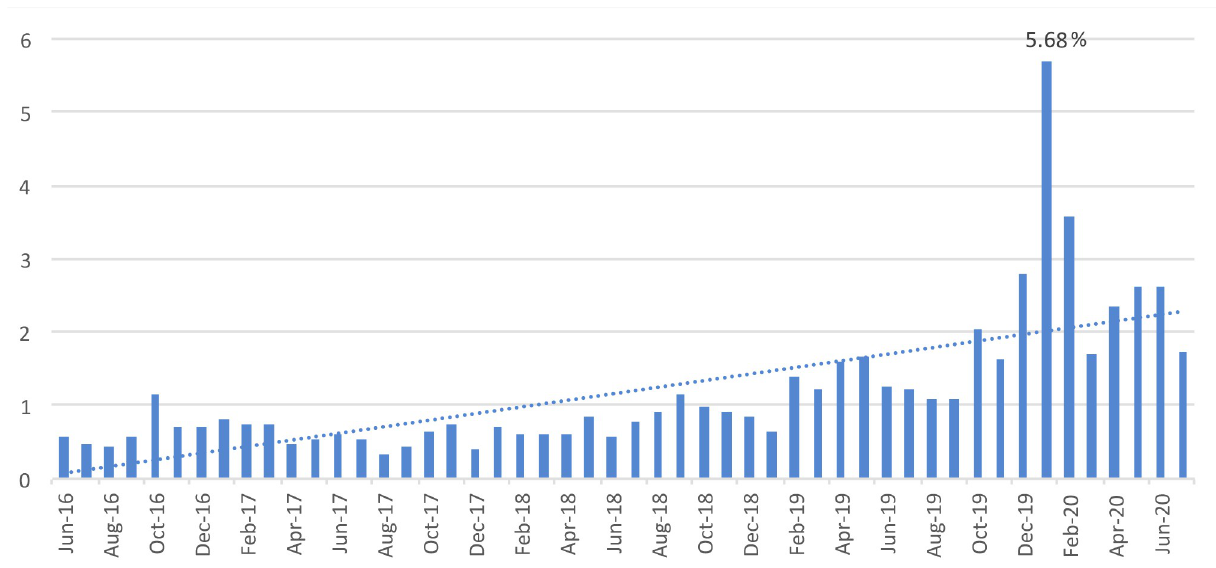
Fig 4. Percentage of scabies cases to total reported consultations at the centers hosting refugees/asylum seekers, for all causes, per month.